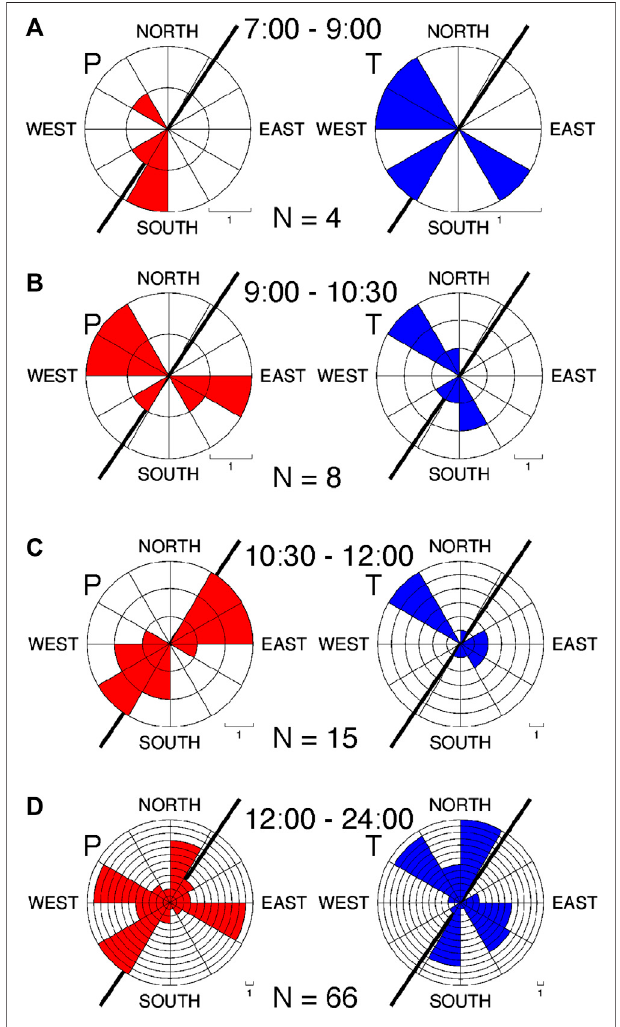
FIGURE 12 | Rose diagrams showing the frequency distribution of the azimuthsoftheP-axis(red)andT-axis(blue)forthetimeperiods: (A) 7:00to9: 00, (B) 9:00 to 10:30, (C) 10:30 to 12:00, and (D) 12:00 to 24:00 JST on August 15,2015.Therosediagramshavea30 ° interval.Eachbinshows one frequency. The number of events whose P- and T-axes were determined for each time period is also shown. The thick line in each diagram shows the strike direction of the dike source of the ground deformation associated with the VT earthquake swarm (Hotta et al., 2016a).